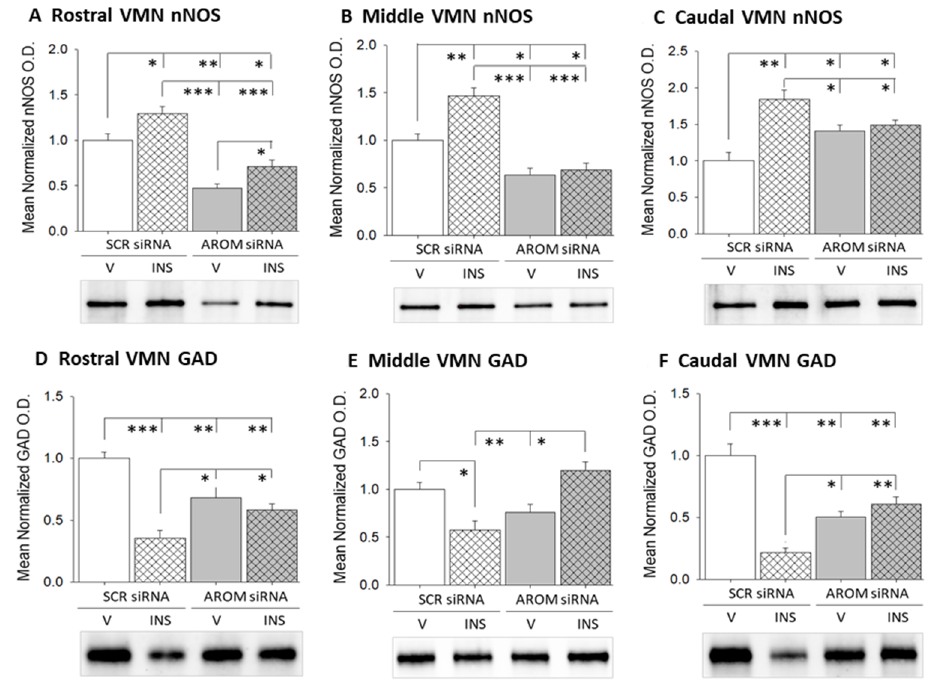
Figure 2. Impact of VMN aromatase gene knockdown on rostral, middle, and caudal VMN gluco- stimulatory and gluco-inhibitory transmitter marker protein expression in V-versus INS-injected rats. Data show mean normalized neuronal nitric oxide synthase (nNOS) (( A ), rostral VMN; ( B ), middle VMN; ( C ), caudal VMN) and glutamate decarboxylase 65/67 (GAD) (( D ), rostral VMN; ( E ), middle VMN, ( F ), caudal VMN) protein O.D. values + S.E.M. for SCR siRNA/V (solid white bars; n = 4), SCR siRNA/INS (diagonal-striped white bars; n = 4), AROM siRNA/V (solid gray bars; n = 4), AROM siRNA/INS (diagonal-striped gray bars; n = 4) treatment groups. * p < 0.05; ** p < 0.01; *** p < 0.001.